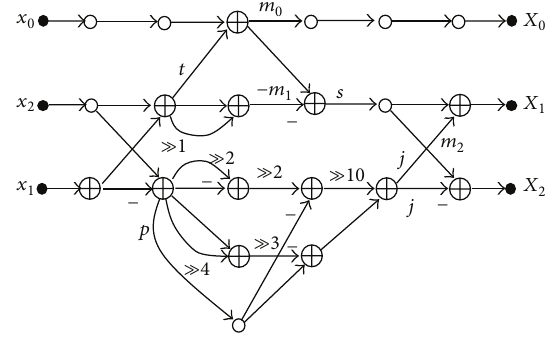
Figure 1: SDF of the 3-point DFT.